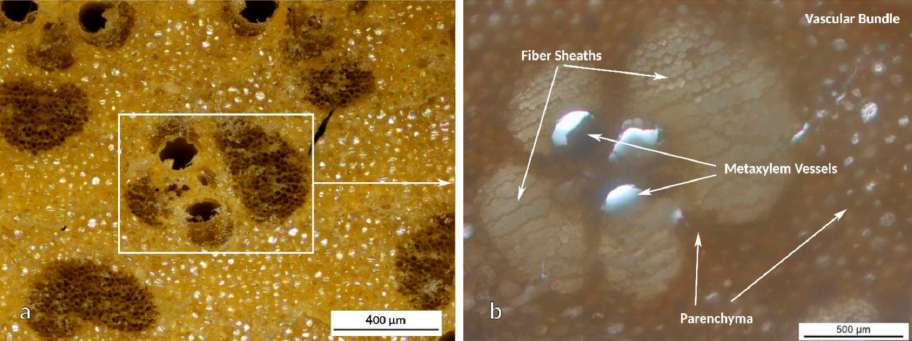
Figure 3. OM micrographs from the cross-section of AA bamboo: ( a ) transversal cut and ( b ) vascular bundle in